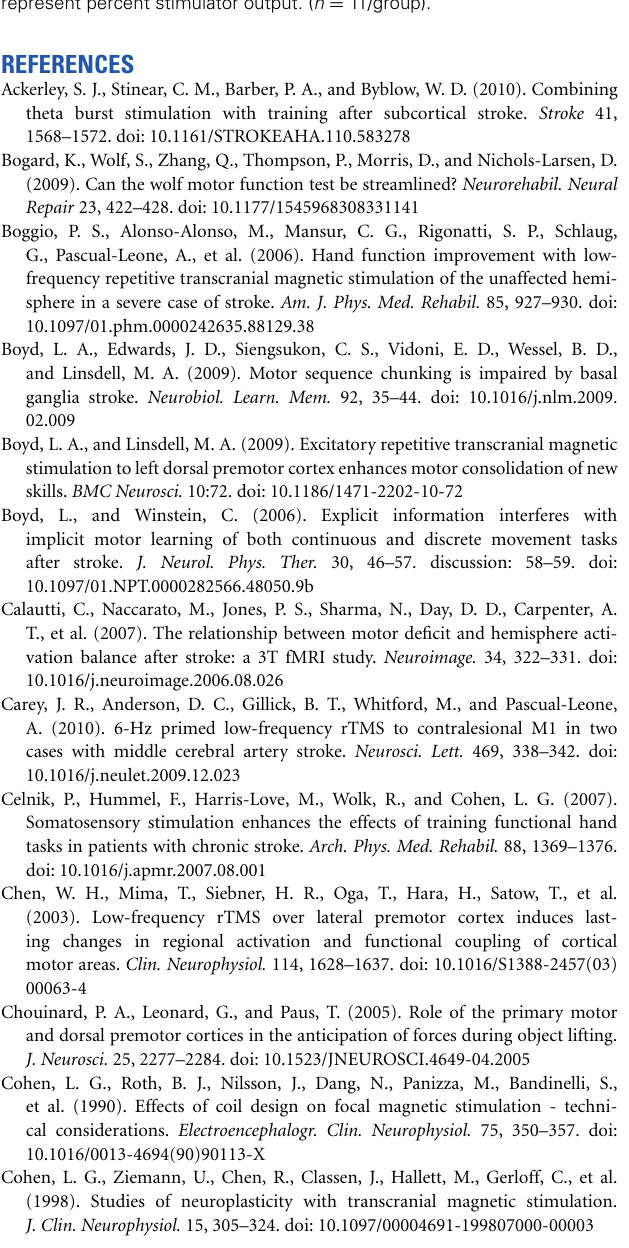
Supplementary Figure 1 | Individual resting motor threshold (RMT) values at baseline and retention by stimulation type. Values in the first column represent subject number. Values in the second and third columns represent percent stimulator output. ( n =